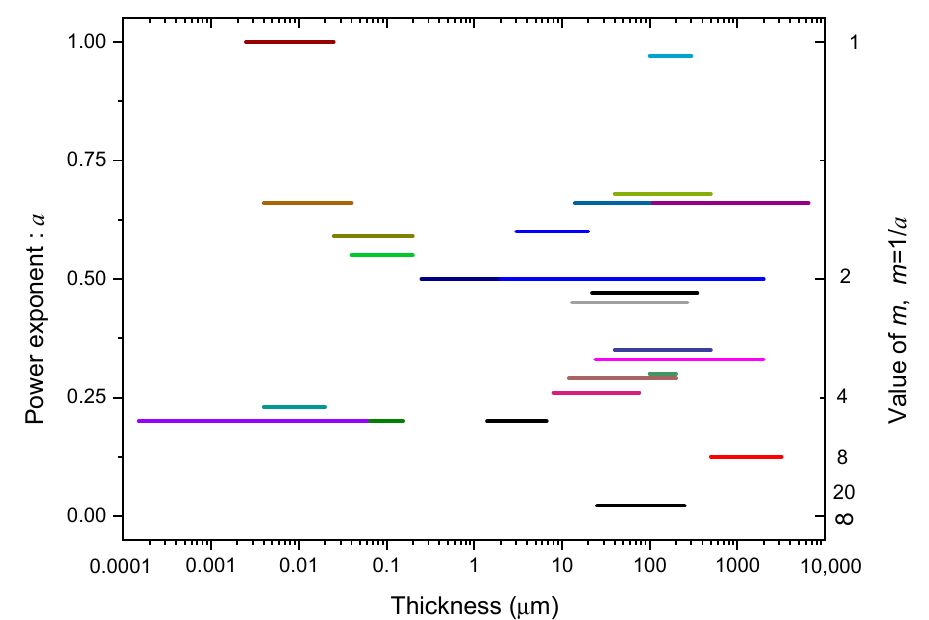
Figure 5. The distribution of a or m ( = 1 / a ) in a wide thickness range based on the data summarized in Table 3.